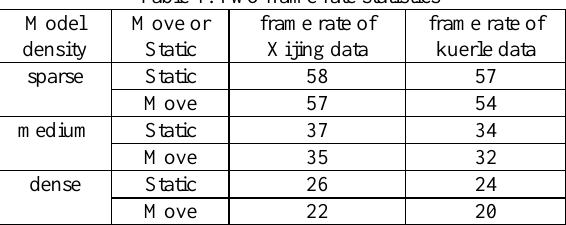
Table 1. Two frame rate